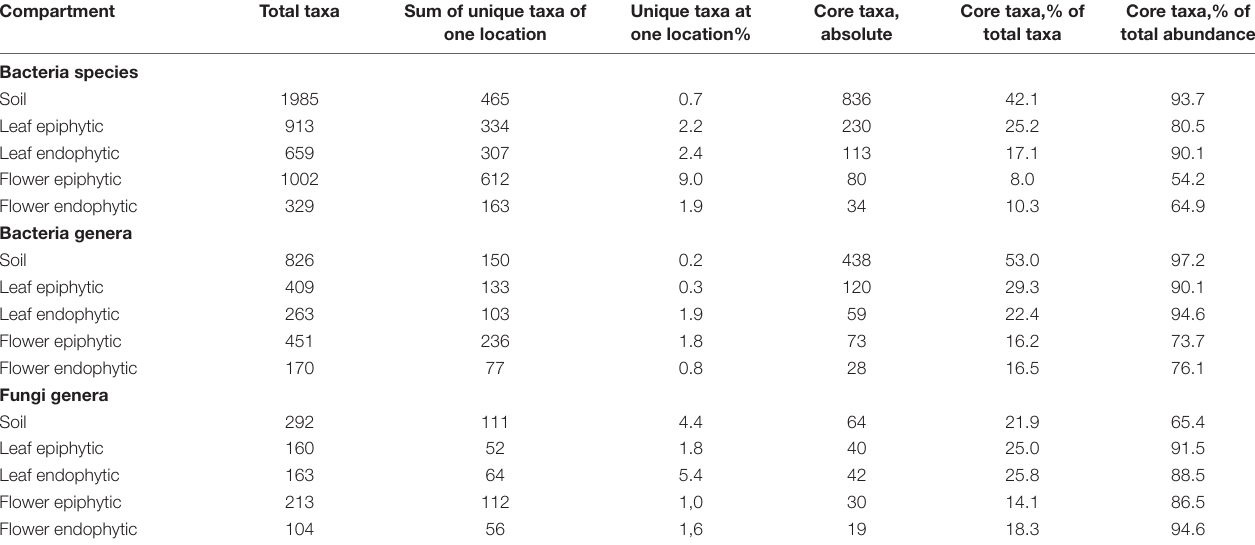
TABLE 2 | Detected bacterial species and genera and fungal genera of the different plant compartments of Achillea at four different locations (for locations see Table 1 ).